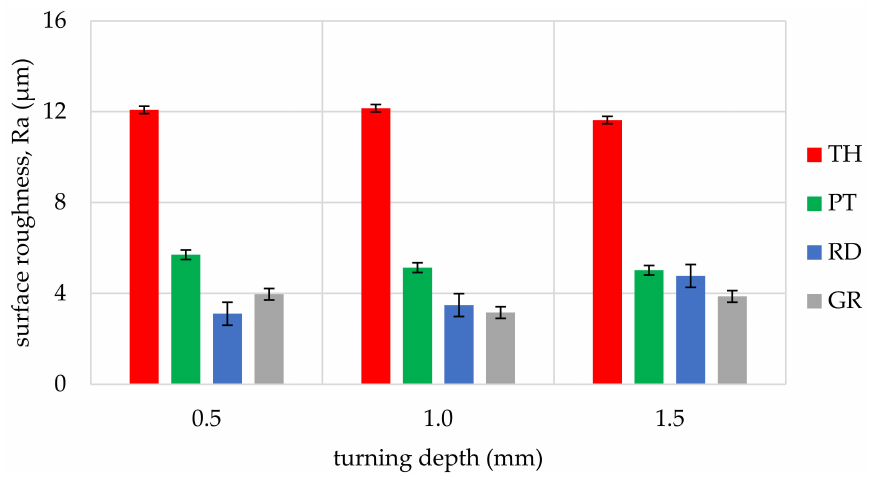
Figure 8. Influence of turning depth and type of cutting insert on surface roughness of Rio Rosewood, Dalbergia nigra (RW).